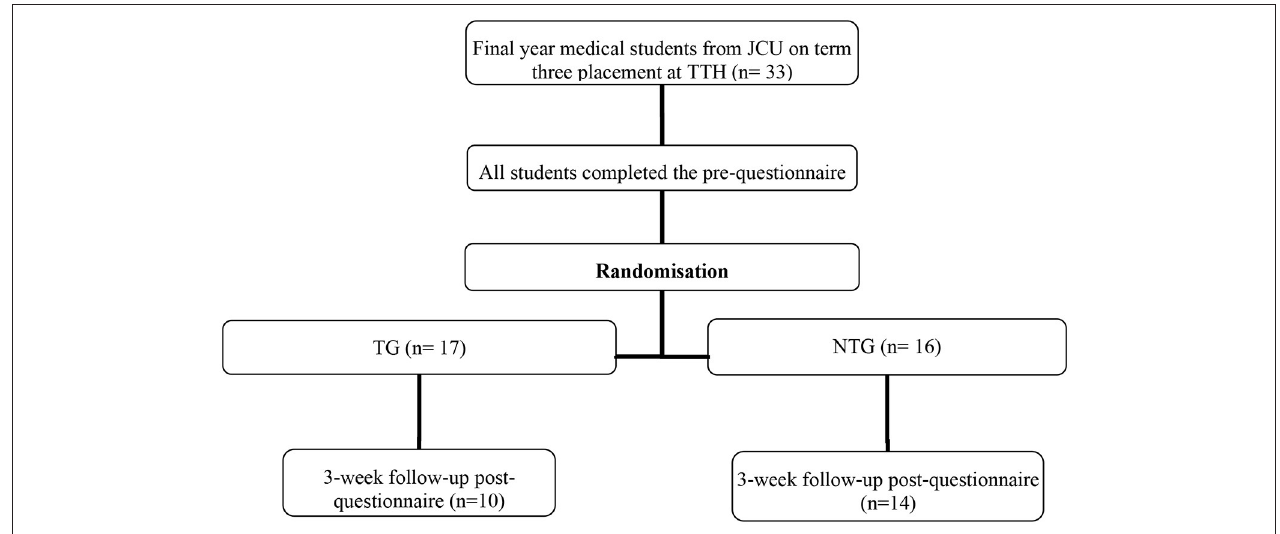
FIGURE 1 | Research design and participant flow. N. B. Students in the TG ( n = 7) and NTG ( n = 2) were lost to follow-up due to placement